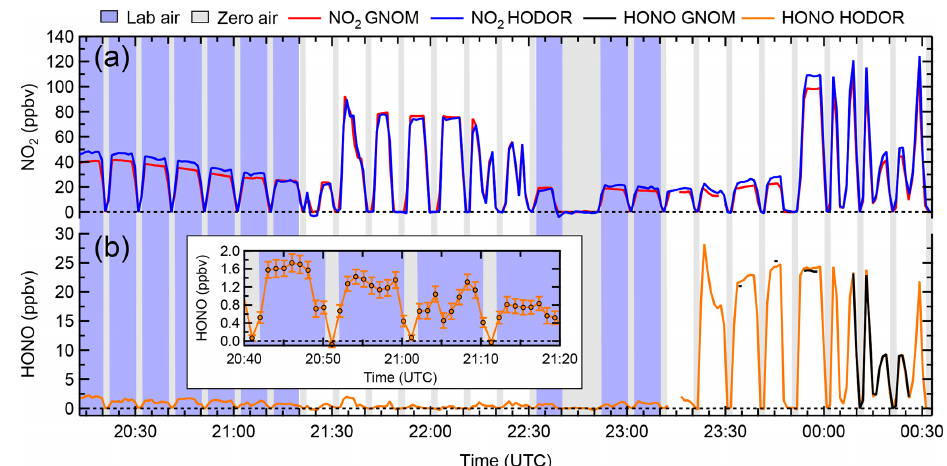
Figure 5. Time series of NO 2 and HONO mixing ratios observed by HODOR, CRDS and TD-CRDS, averaged to 1min. The instruments sampled for zero air (grey underlay), laboratory air (blue underlay) and laboratory air to which varying amounts of synthetic air containing NO 2 , HONO and zero air were added (white underlay). (a) NO 2 mixing ratios reported by IBBCEAS (HODOR, blue) and CRDS (GNOM, red). (b) HONO mixing ratios reported by TD-CRDS (black) and IBBCEAS (orange). From 23:30 to 00:10UTC, the TD-CRDS inlet converter temperature was ramped up and down several times to collect a thermogram; only data collected at an inlet temperature > 520 ◦ C are shown here. The inset shows the mixing ratio of HONO in laboratory air containing 40–50ppbv of NO 2 . The error bars show the measurement uncertainty of